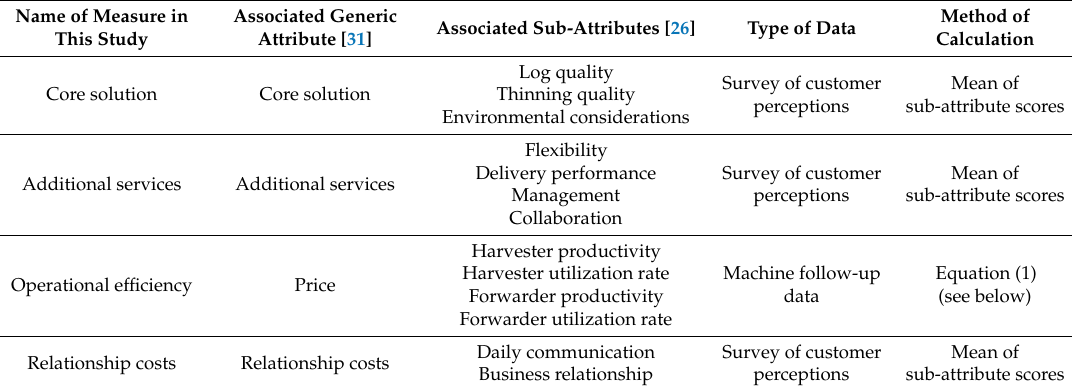
Table 1. Schematic view of the measures of customer-perceived value as used in this study. Name of Measure in Associated Generic This Study Attribute